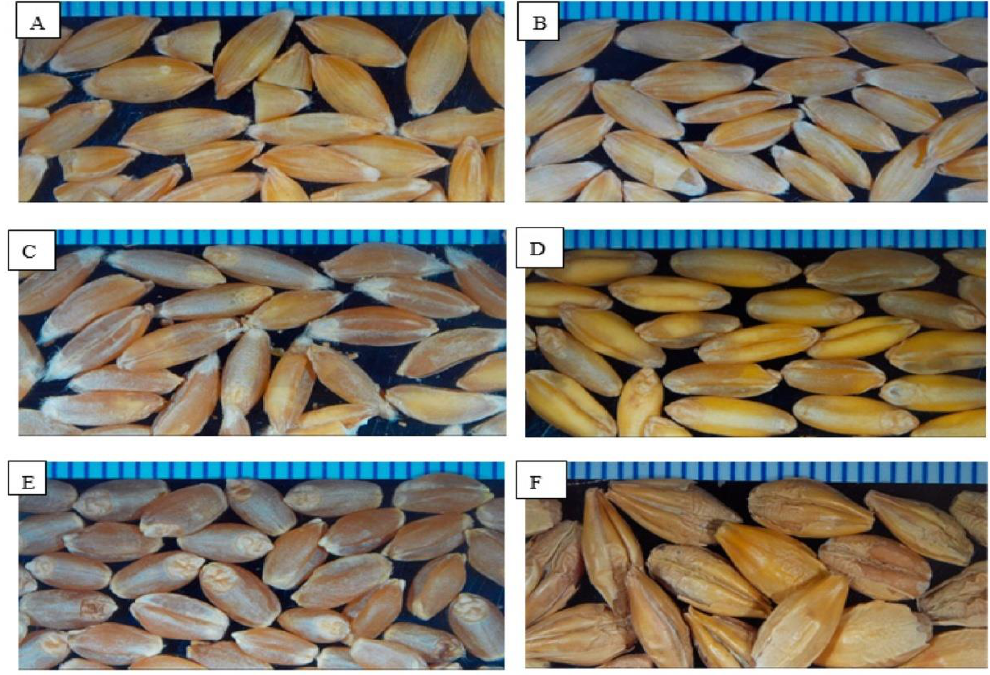
Figure 1. Ancient cereal grains, where: ( A ) einkorn, ( B ) emmer, ( C ) spelt, ( D ) durum, ( E ) Hard Red Spring wheat and (F) barley. Taken from Fujita et al. [25]. Copyright 2020 Creative Common Attribution License.